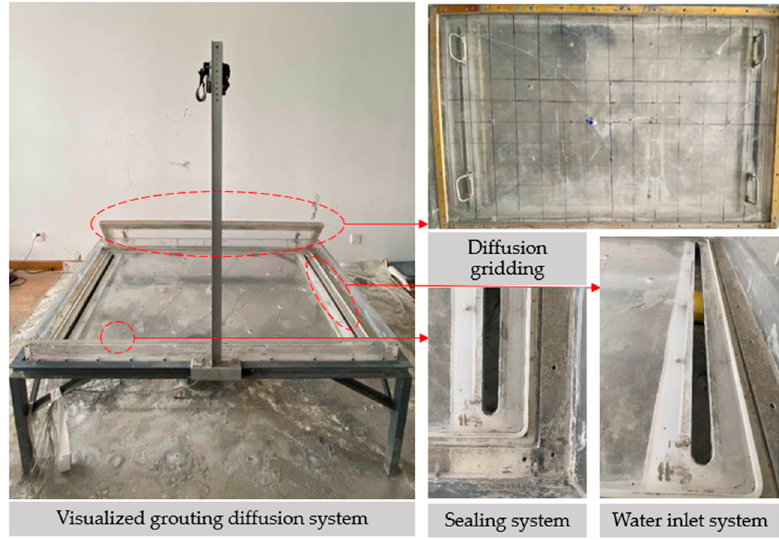
Figure 6. Visualized grouting diffusion system.